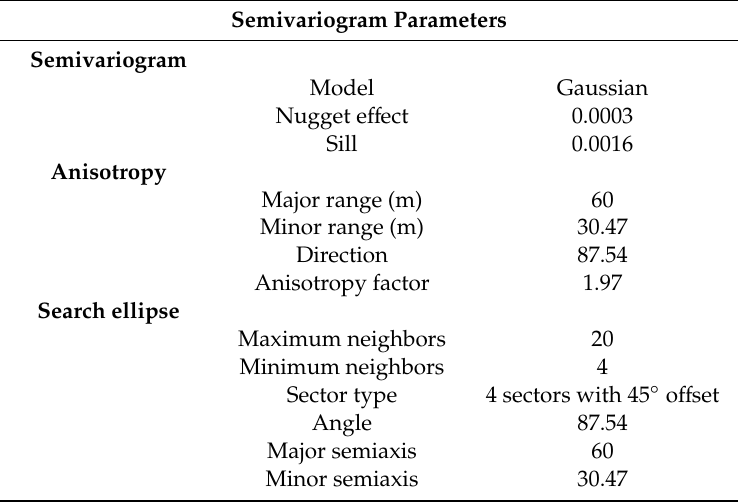
Table 3. Cross-validation (CV) error values.